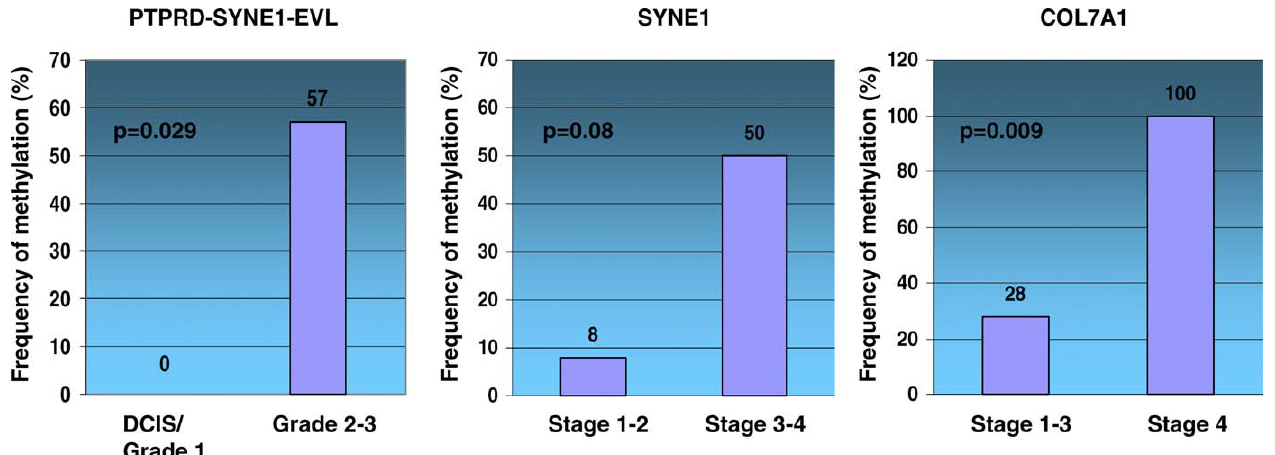
Figure 9. Hypermethylation of Selected ‘‘ Common Target ’’ Genes Predict for Poor Clinical Prognosis Hypermethylation of selected common target genes by grade and stage in primary breast tumors. The first graph shows the frequency of methylation of at least one of the three genes listed in low- versus high-grade breast tumors. The second (SYNE1) and third (COL7A1) graphs show the frequency of methylation of the indicated genes in different stages of breast cancer. p -Values are adjusted using the Holm method.